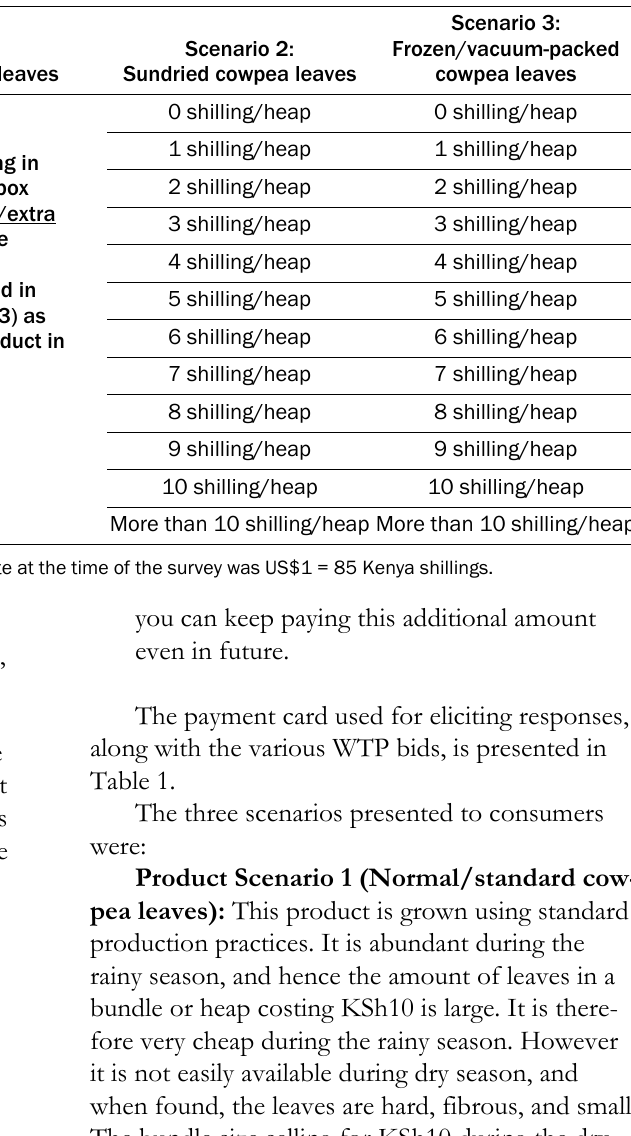
Table 1. Payment Card Illustrating the Distribution of Willingness To Pay